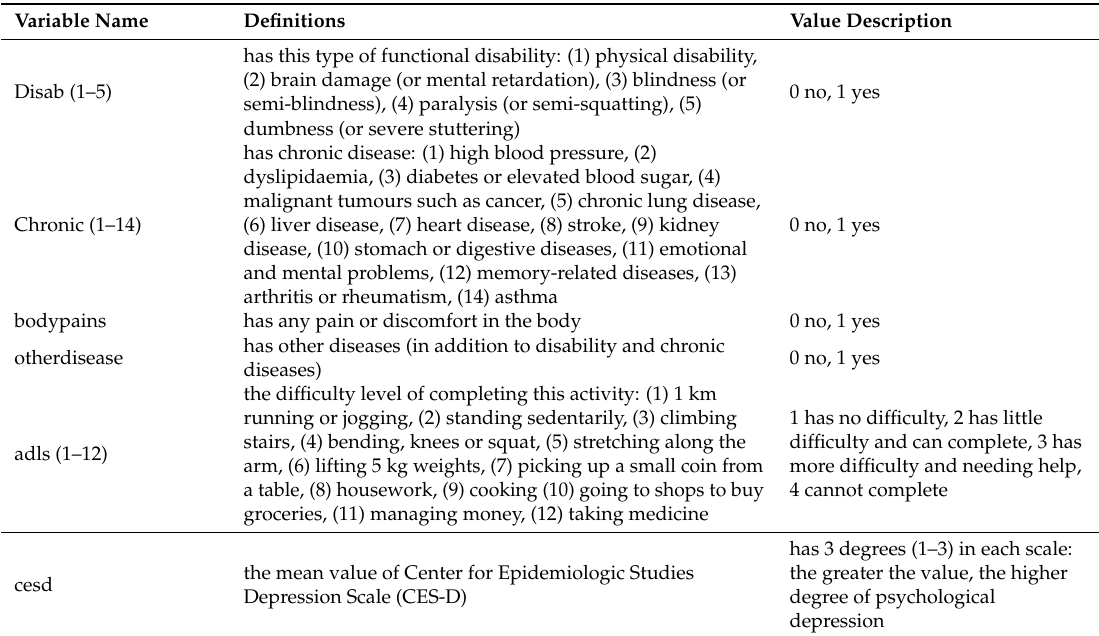
Table A1. The description of objective